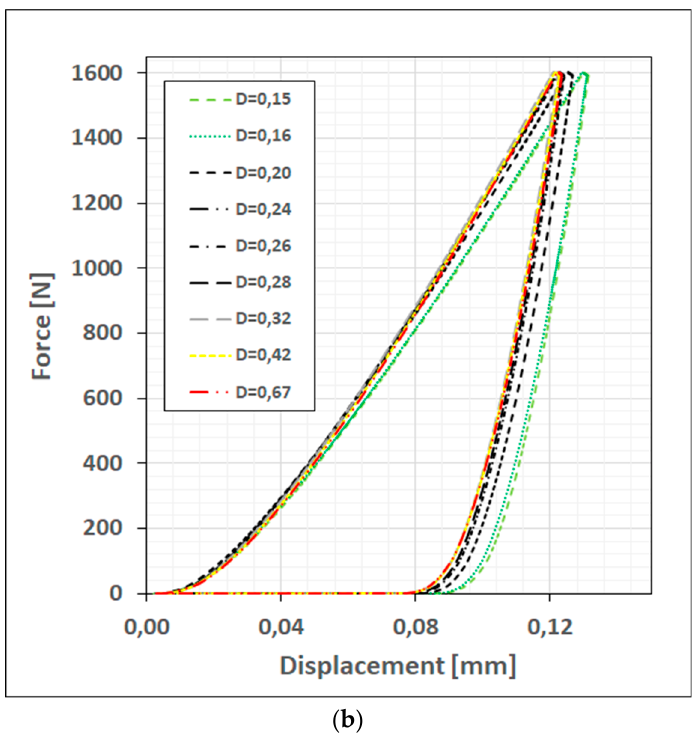
Figure 10. HCF tested specimen: ( a ) gage part of the specimen after indentation tests; ( b ) and indentation force–displacement plots.